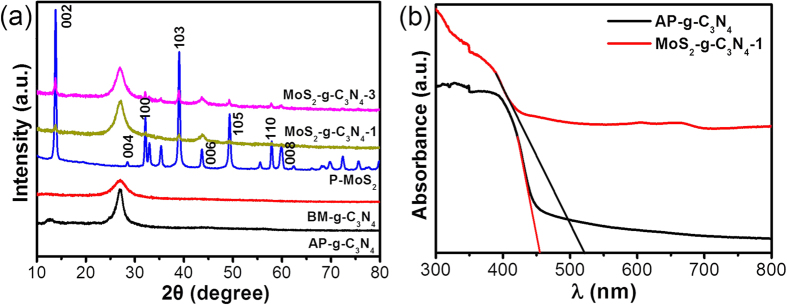
(a) XRD patterns of AP-g-C3N4, BM-g-C3N4, P-MoS2, MoS2-g-C3N4-1, and MoS2-g-C3N4-3 heterostructure and (b) UV-visible diffuse absorbance spectra of AP-g-C3N4 and MoS2-g-C3N4-1 heterostructure with direct band gap measurement.